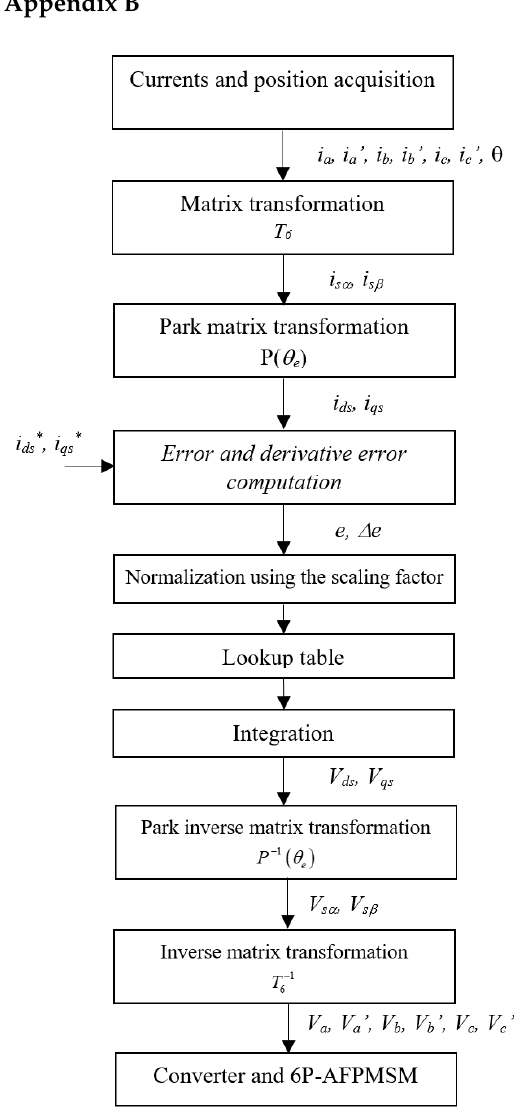
Figure A1. Flowchart of the overall process.